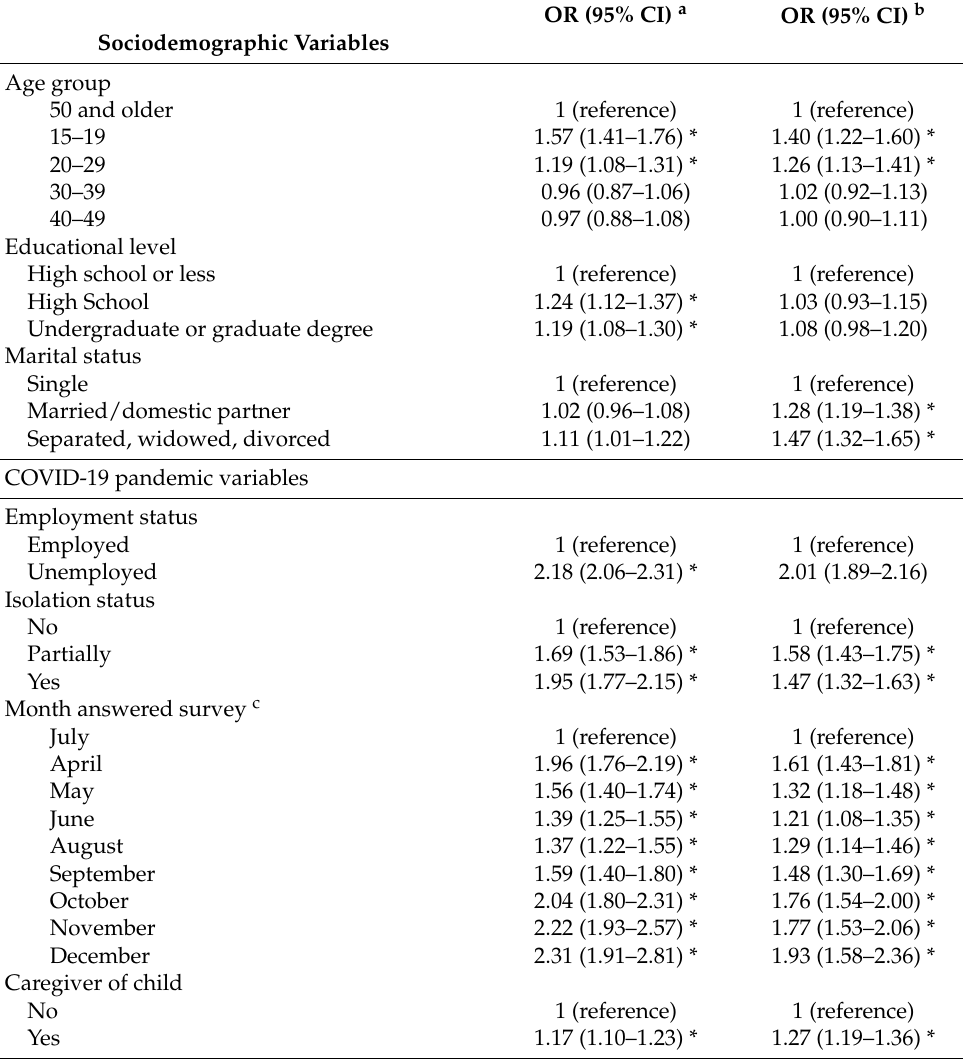
Table 3. Factors Associated with Domestic Violence Against Women During the COVID-19